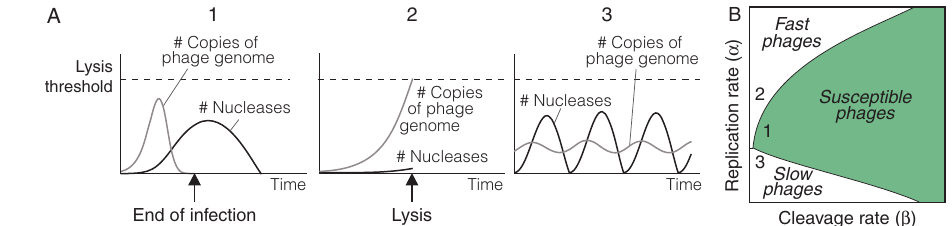
β in Model 1, respectively). Within this space, phages can be classi fi ed into three functional categories: (1) Phages susceptible to the action of nucleases as the one showninA1,(2)phageswithhighreplicationratesthatoutrunnucleases(likeinA2), and (3) phages with low replication and cleavage rates that induce oscillations in thenumberofnucleasespresentinthecytoplasmoftheinfectedbacterialcell(like in A3). Based on the dynamics shown in ( A ), we will label these types of phages as susceptible,fast,andslow,respectively.Thedetailsofthesimulationsareprovided in the “ Methods ”